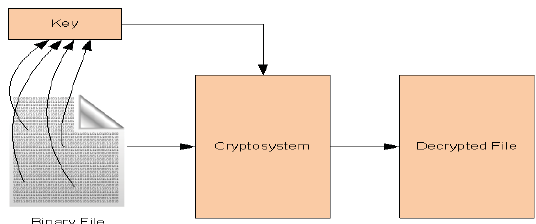
Fig.2. Decryption